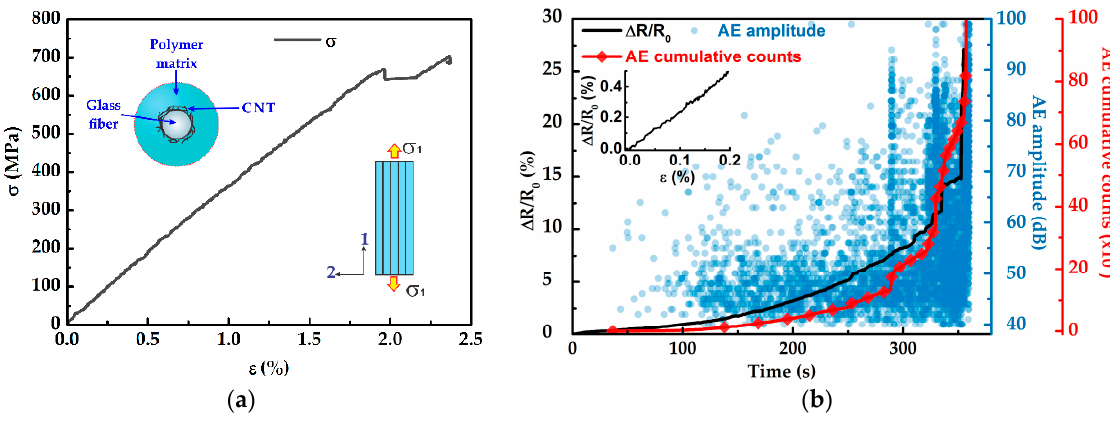
Figure 5. Mechanical, electromechanical, and acoustic emission characterization of the composite with architecture f . ( a ) Stress-strain curve, ( b ) evolution of ∆ R/R 0 (continuous line), AE amplitude (circles), and AE cumulative counts (diamonds) during the tensile test.